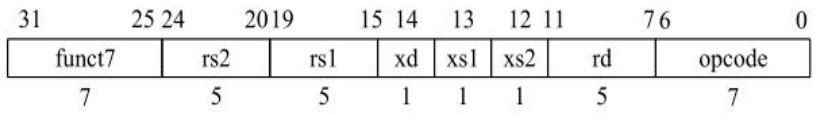
Figure 7. The 32-bit custom instruction encoding format.